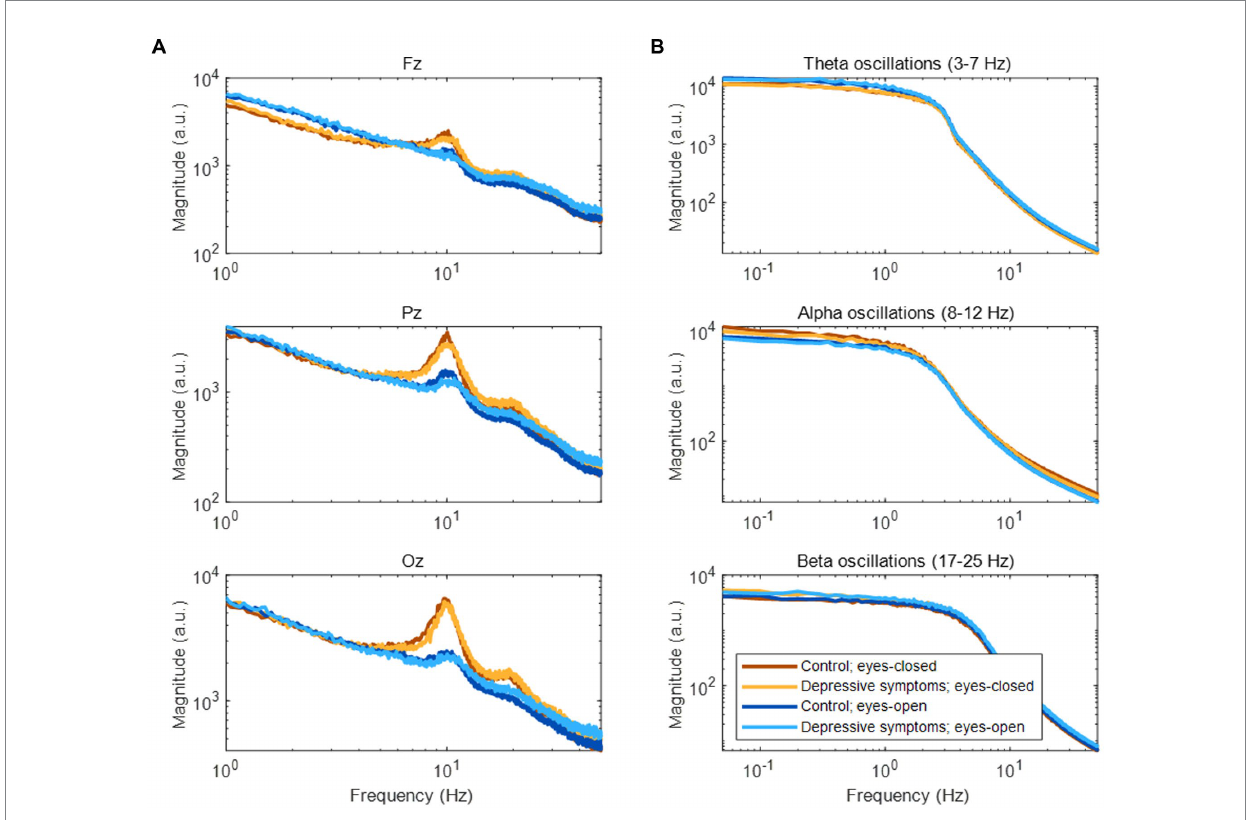
FIGURE 3 Frequency components of EEG and amplitude fluctuations of EEG oscillations. (A) Frequency components of EEG during rest. (B) Frequency components of amplitude fluctuations according to three EEG oscillations at the Fz